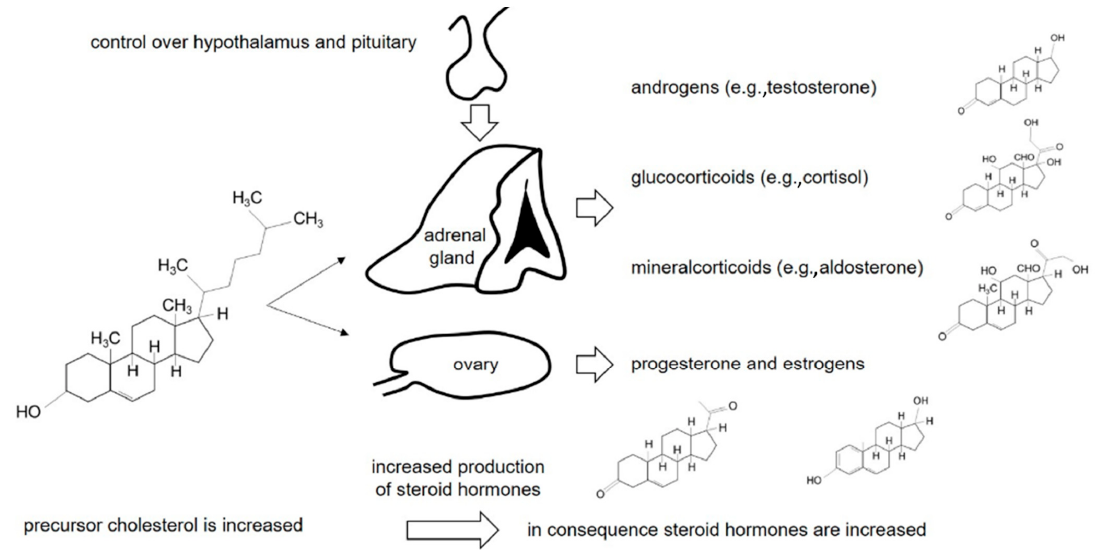
Figure 1. The potential mechanism of increased steroid hormones in affected autistic individuals. The increased availability of the precursor cholesterol yields control of the hypothalamus pituitary adrenal gland (HPA) to the corticotropin-releasing hormone (CRH)-adrenocorticotropic hormone (ACTH) system and ovary and leads to increased metabolites, such as testosterone or cortisol, which alter critical developmental steps leading to autistic disorders.